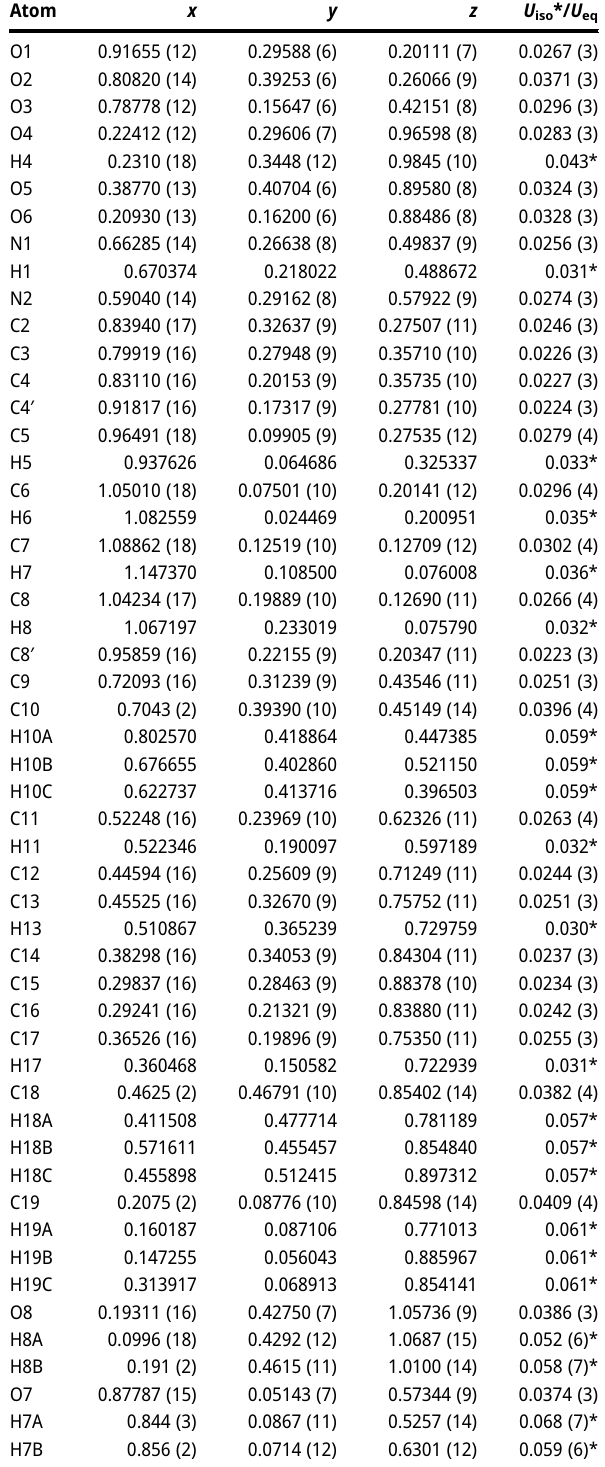
Table  : Hydrogen-bond geometry.